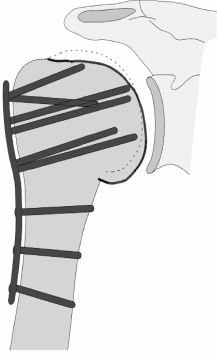
Figure 6. Complication Type 1. Middle: measurement of varus displacement on an a.p. radiograph of a right shoulder after angular stable plate osteosynthesis. The varus displacement is 16° relative to the anatomic CCD angle of 135°. No screw cutout results.